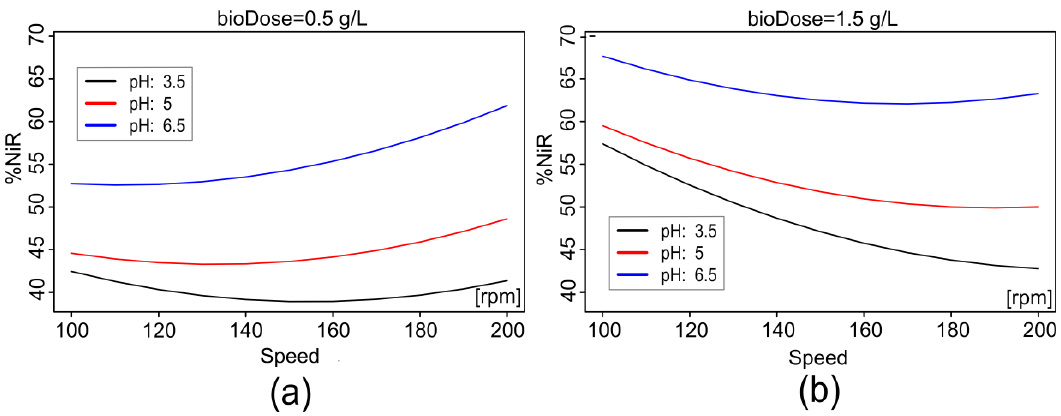
Figure 5. %NiR vs. S for di ff erent values of pH when: ( a ) bioDose = 0.5 g / L; and, ( b ) bioDose = 1.5 g /